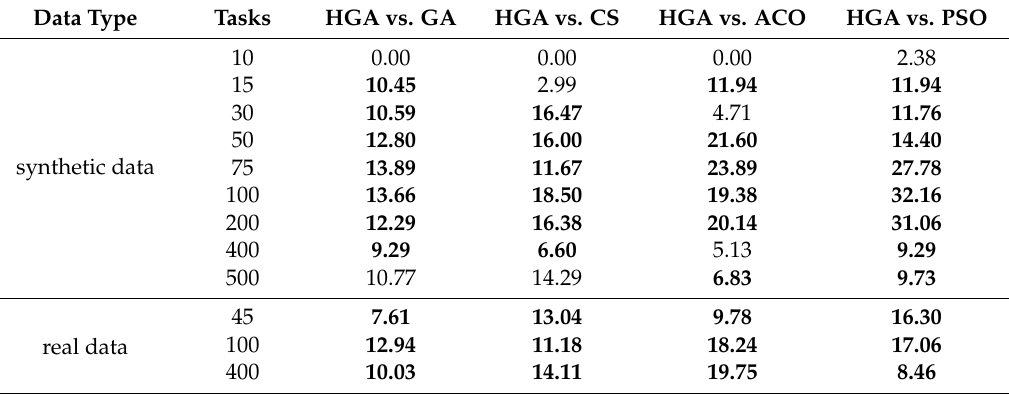
Table 4. Percentage improvement obtained by HGA with respect to GA, CS, ACO, and PSO. Statistically significant results are shown in